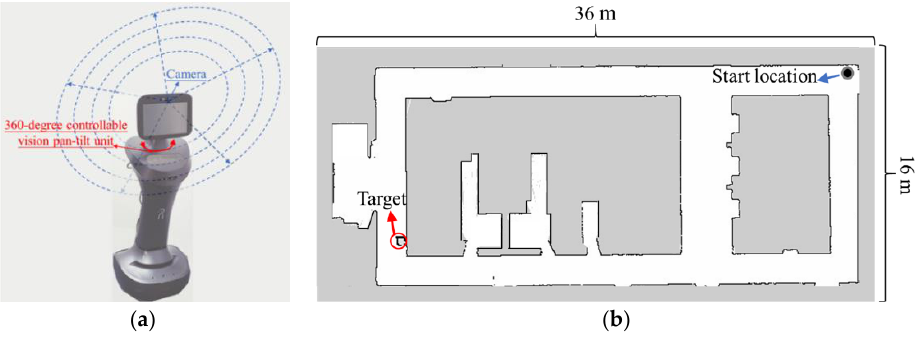
Figure 15. ( a ) A mobile robot for target searching; ( b ) a real test environment.